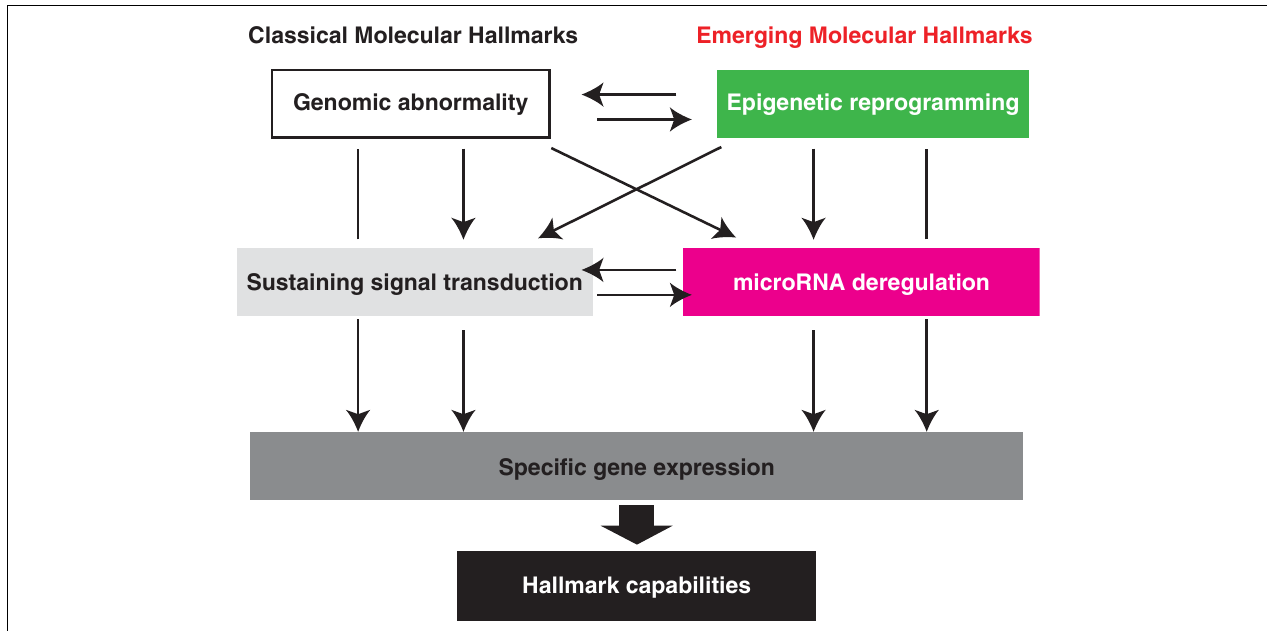
downstream molecular capabilities. Deregulation of the cellular miRNA levels directly influence hundreds of genes expression. Importantly, cross talking among each category can attain more complex gene regulatory network that is indispensable for exercise of various functions at appropriate